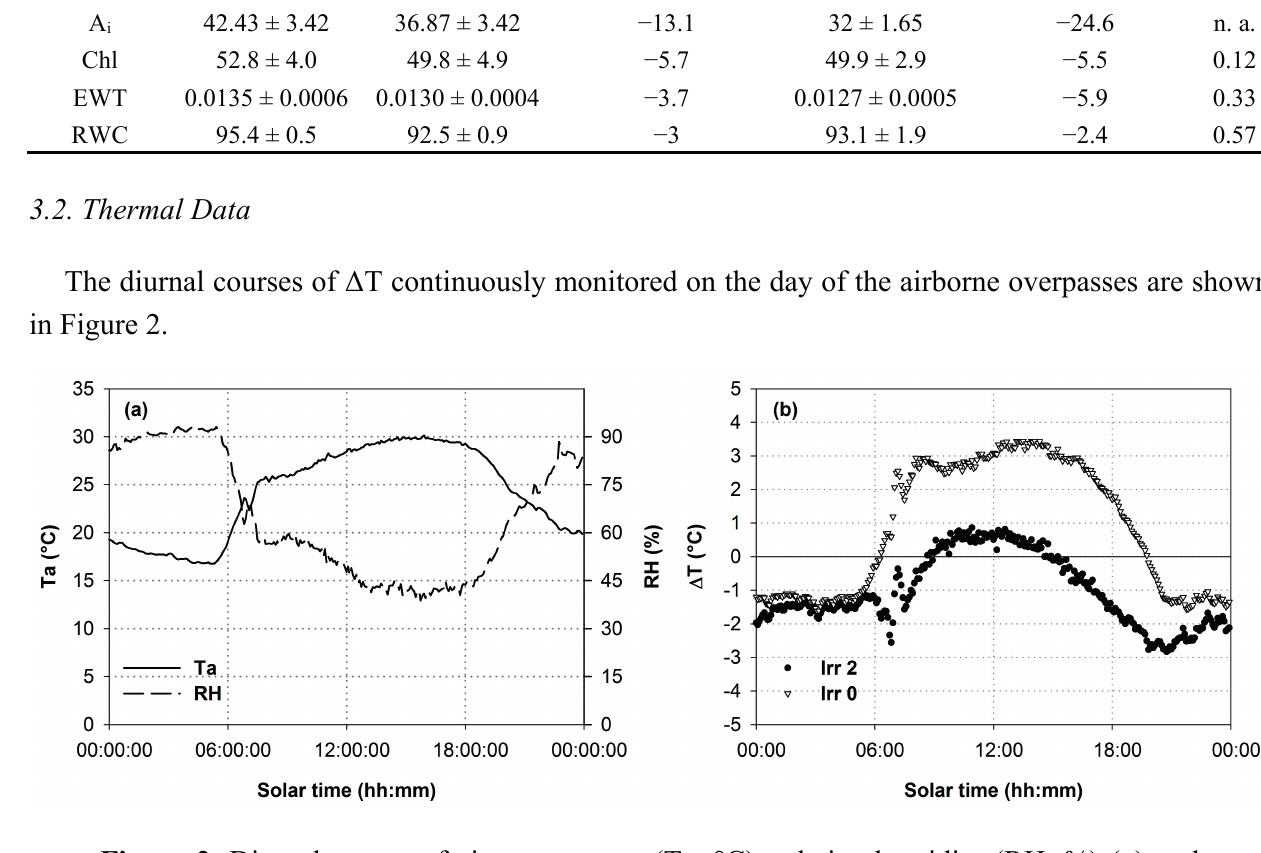
Figure 2. Diurnal course of air temperature (Ta, °C), relative humidity (RH, %) ( a ) and difference between canopy and air temperature ( Δ T, °C) ( b ) for the two plots (one Irr0 and one Irr2) continuously monitored on the day of the airborne